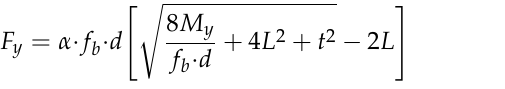
Table 5. Comparison of the strength values of the composite joints in different approaches. Specimen